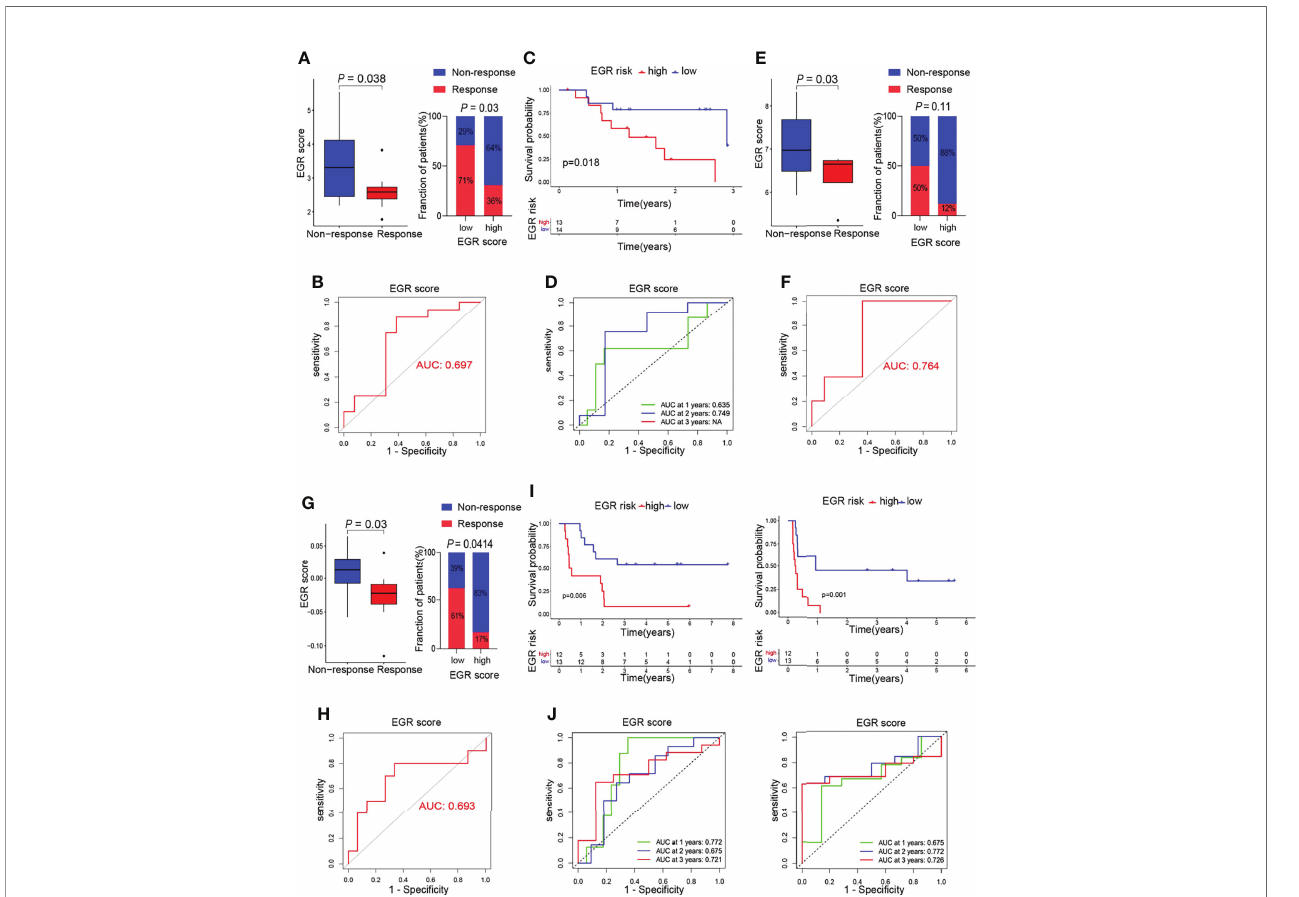
FIGURE 5 | Association of m6Ascore and response to immunotherapy. (A) Boxplot of response of immunotherapy between EGRscore-low and EGRscore-high HCC patients. (B) ROC curves based on EGRscore in the GSE78220 cohort. (C) Kaplan – Meier survival analysis based on EGRscore in the GSE78220 cohort. (D) Time- dependent ROC curves based on EGRscore in the GSE78220 cohort. (E) Boxplot of response of immunotherapy between EGRscore-low and EGRscore-high HCC patients in the GSE126044 cohort. (F) ROC curves based on EGRscore in the GSE126044 cohort. (G) Boxplot of response of immunotherapy between EGRscore-low and EGRscore-high HCC patients in the GSE100797 cohort. (H) ROC curves based on EGRscore in the GSE100797 cohort. (I) Kaplan – Meier survival analysis for OS and DFS based on EGRscore in the GSE100797 cohort. (J) Time-dependent ROC curves for OS and DFS based on EGRscore in the GSE100797